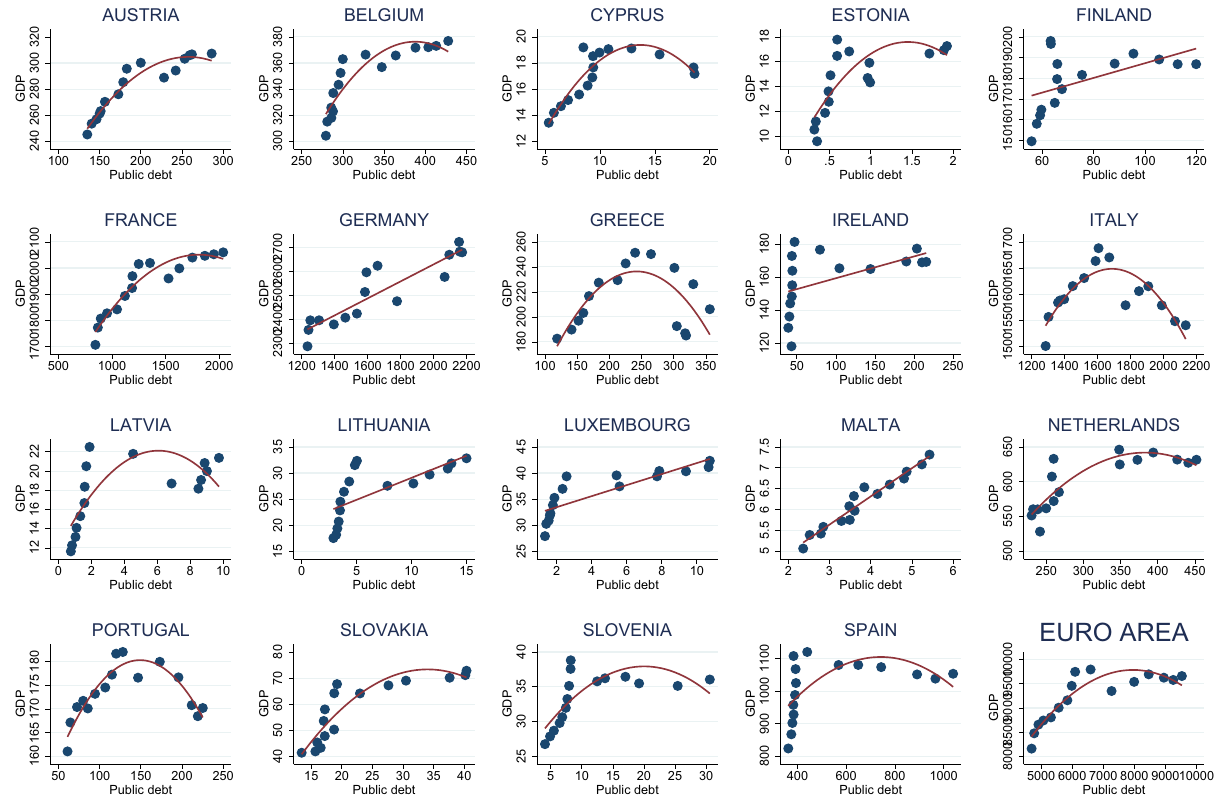
Fig. 1 Output-public debt scatterplots for euro area member states and for the euro area. Each sub-panel describes a given member state ’ s output-public debt scatterplot. Source: Bhimjee and Leão (2020).